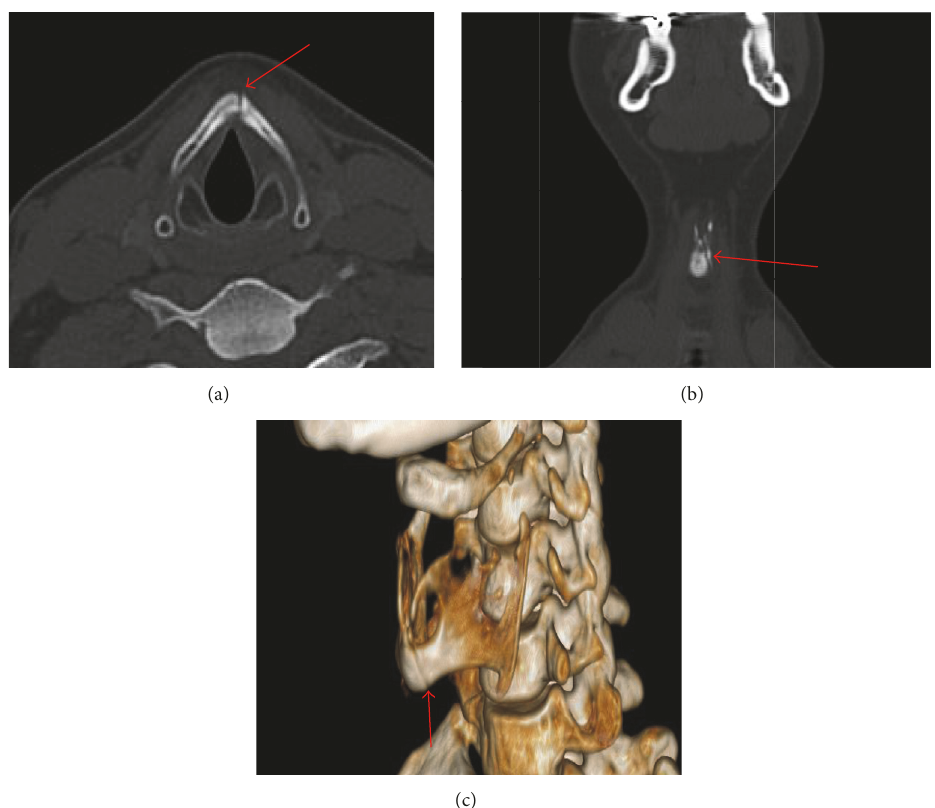
Figure 2: Computed tomography, bone window. Left, complete, and nondisplaced parasagittal fracture that compromises thyroid cartilage (red arrows). (a) Axial view; (b) coronal view; (c) 3D bone reconstruction.